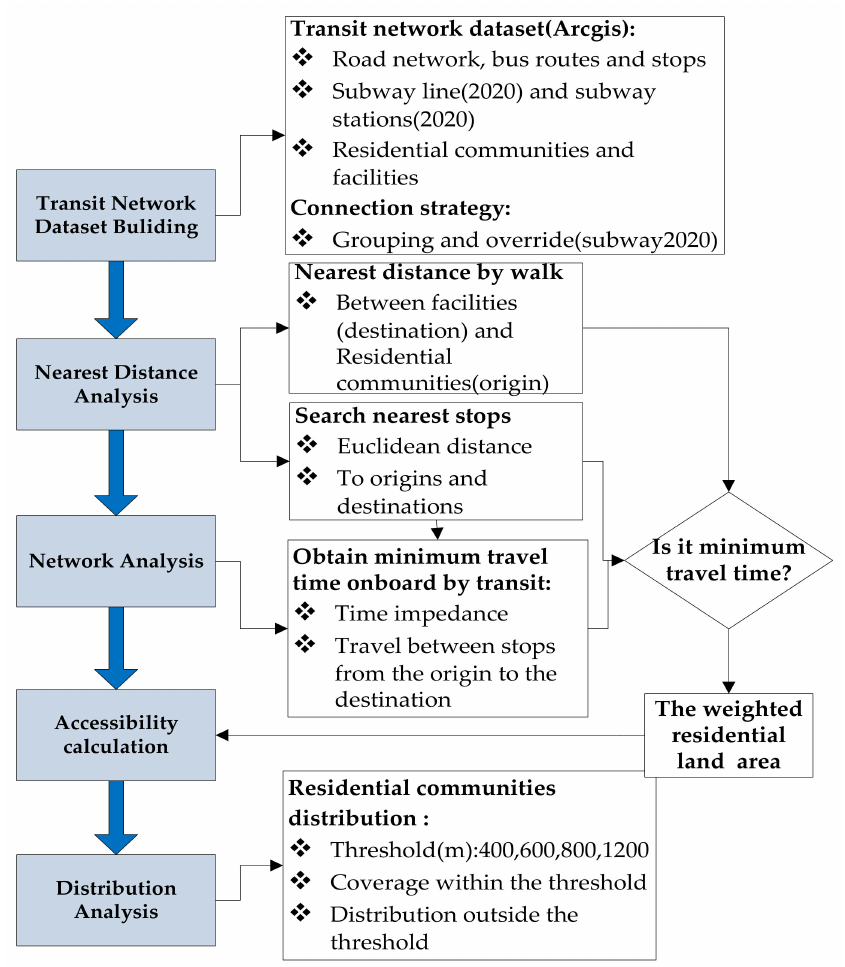
Figure 1. The steps of transit accessibility